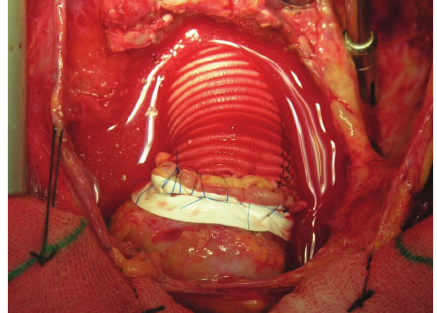
Figure 1: Bentall operation.